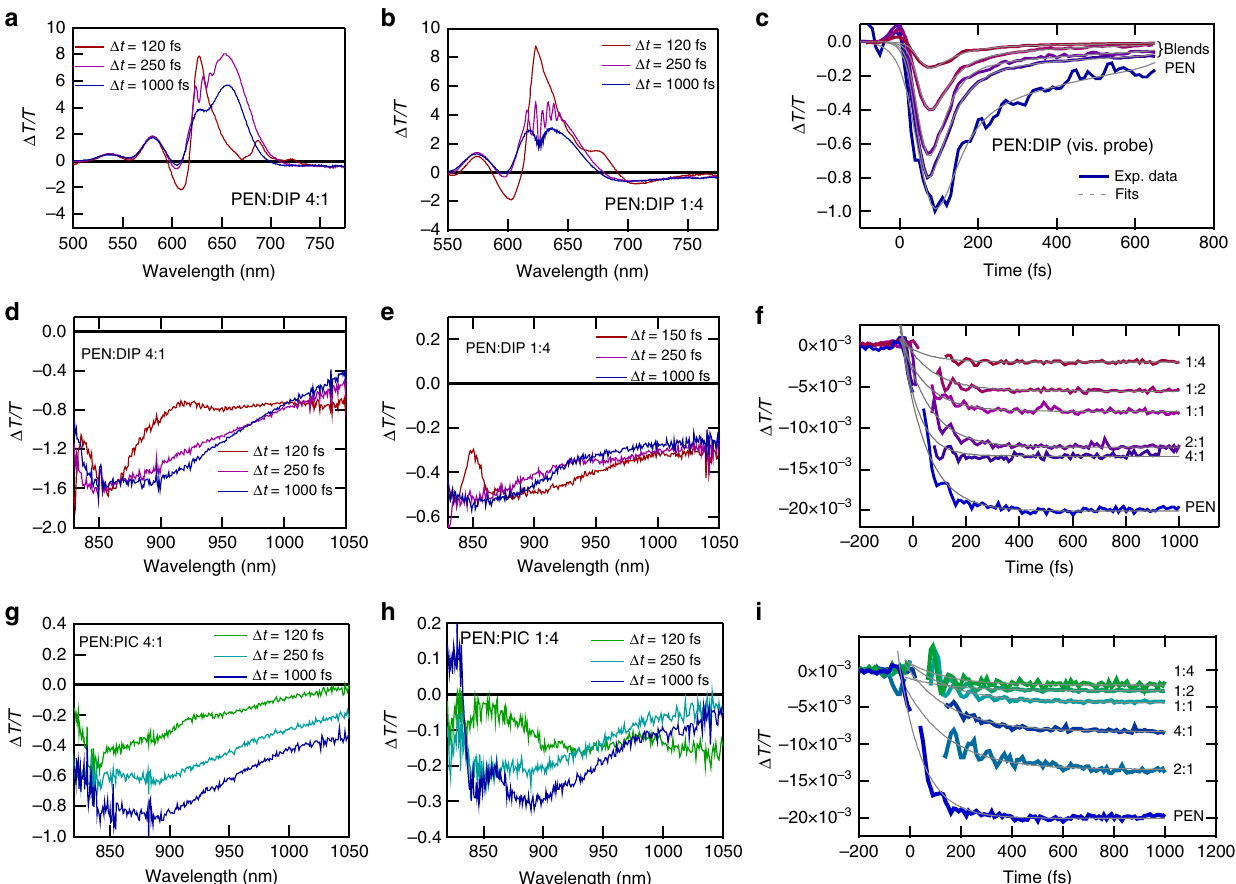
Fig. 4 Photophysics of the blends. a – f TA spectra of two PEN:DIP blends with excitation at 620 nm and corresponding dynamics of all mixing ratios extracted at c 607 or f 875 nm. a – c visible probe, d – f near-infrared probe. g – h TA spectra of two PEN:PIC blends with excitation at 620 nm and near- infrared probe. i Corresponding dynamics of all PEN:PIC mixing ratios extracted at 875